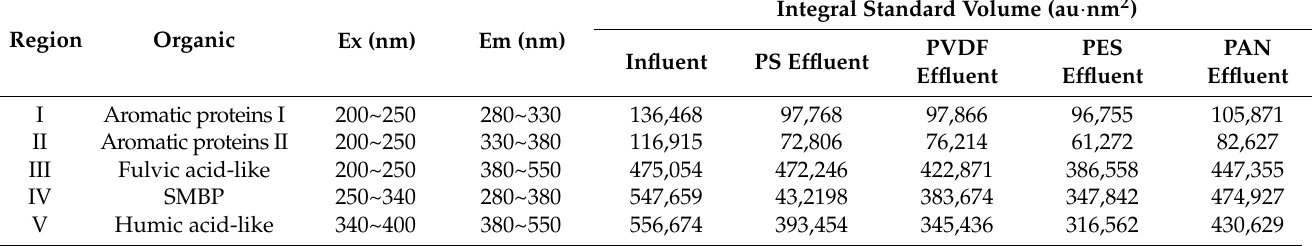
Table 6. The integral standard volume of the fluorescence region before and after ultrafiltration using different membrane